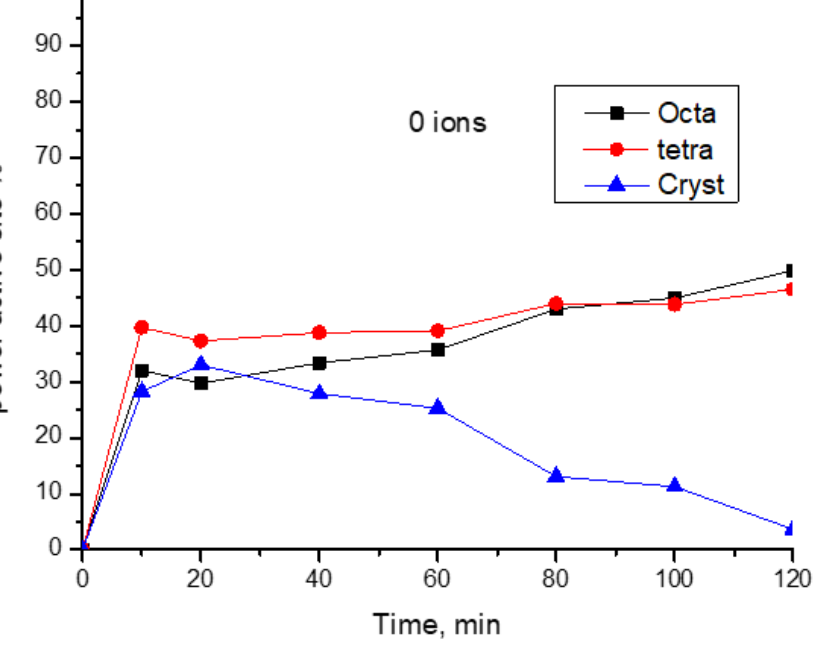
Figure 12. Active power of each active site in the absence of ions.